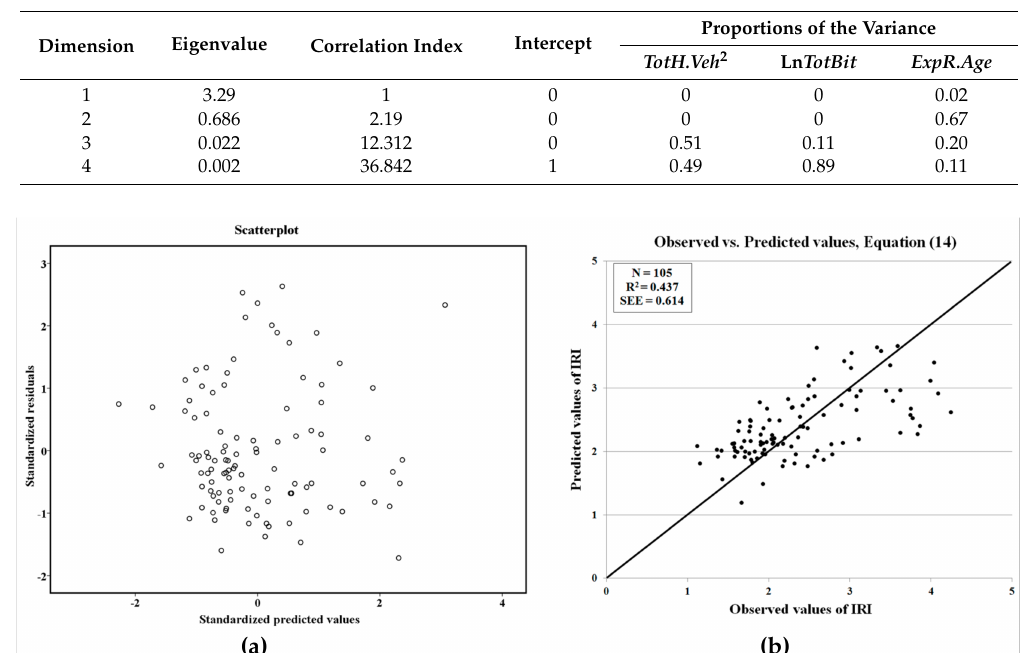
Table 9. Colinearity diagnosis of Equation (14).